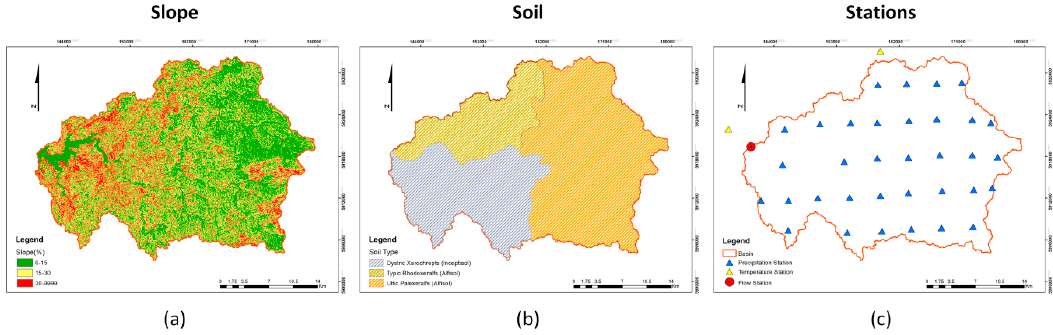
Figure 2. ( a ) Slope map, ( b ) soil types and ( c ) meteorological and flow stations.